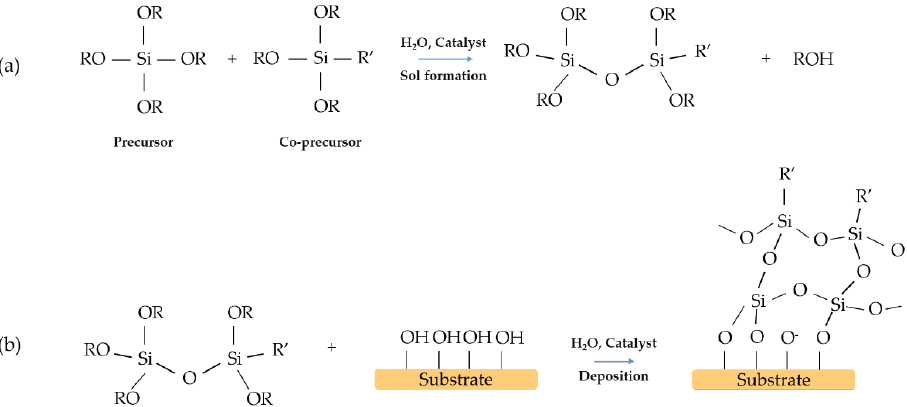
Figure 8. Example scheme of a one-step reaction: ( a ) preparation of the sol, ( b ) deposition of the film on the substrate. R and R’ organic groups. R’ is the functional group covalently bonded to silicon .